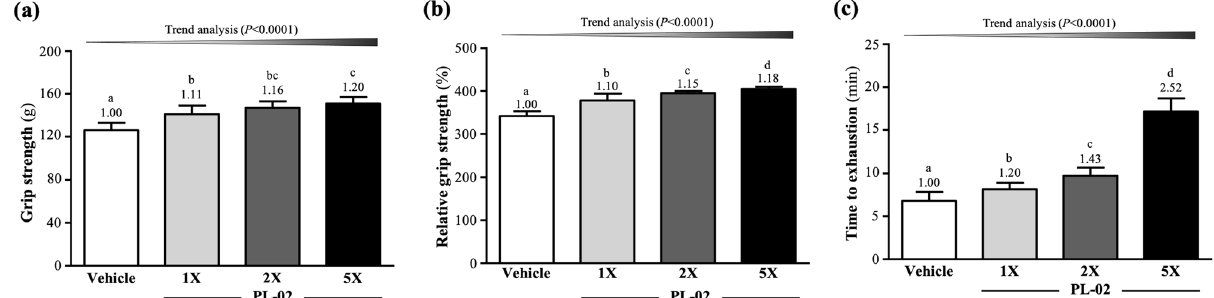
Figure 1. Effect of 4 weeks of PL-02 supplementation on ( a ) absolute forelimb grip strength, ( b ) forelimb grip strength (%) relative to body weight and ( c ) exhaustive swim time. Data are expressed as mean ± SD for n = 10 mice per group. Different superscript letters (a, b, c, d) indicate significant difference at p <